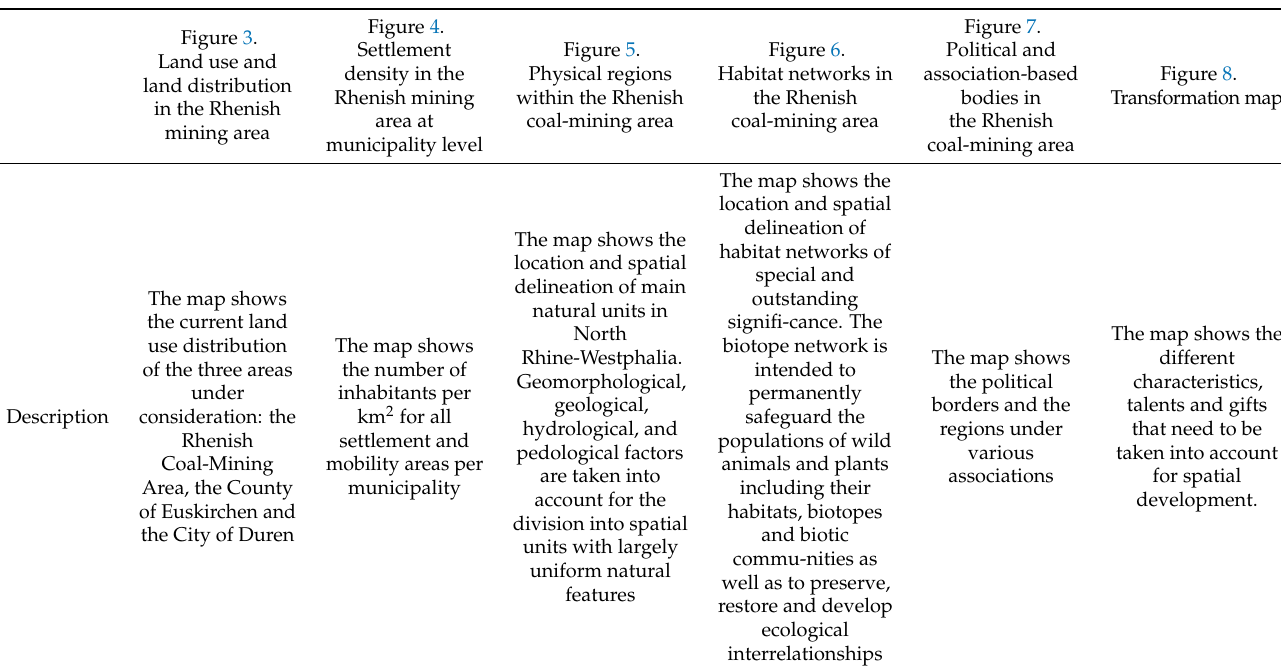
Table 1. Overview on data sources. Figure 4. Figure 3. Settlement Figure 5. Land use and